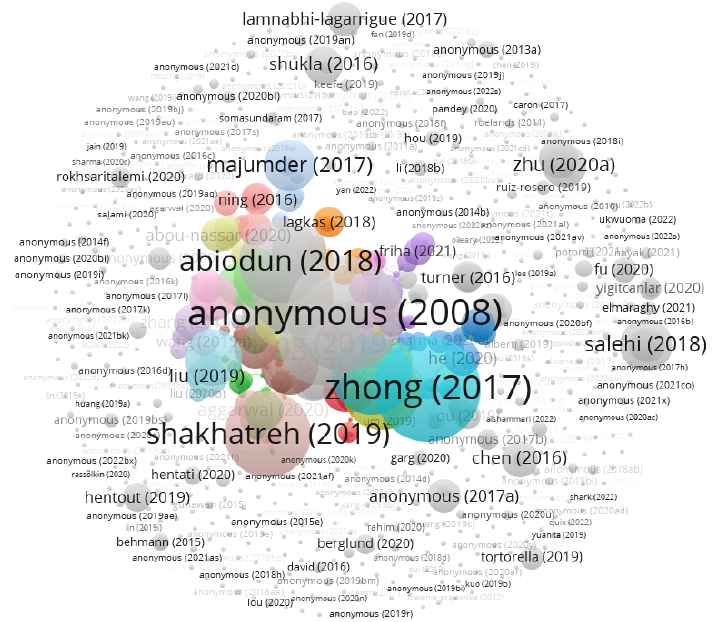
Figure 2. VOSviewer mapping of big data management algorithms, deep learning-based object detection technologies, and geospatial simulation and sensor fusion tools in the Internet of Robotic Things regarding citation.